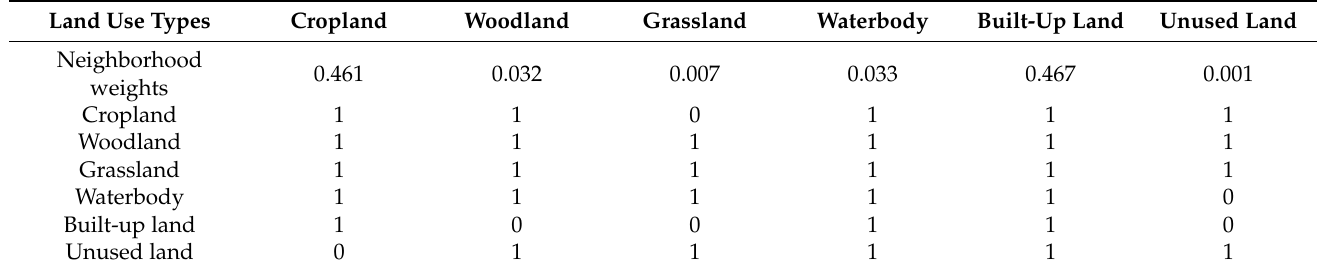
Table 2. Neighborhood weight parameters and transition matrix for the 2010 land use